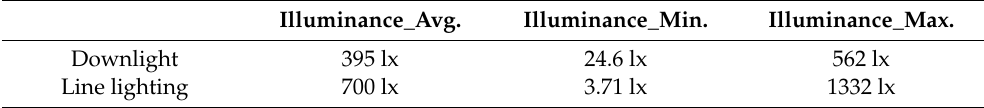
Table 8. Simulation